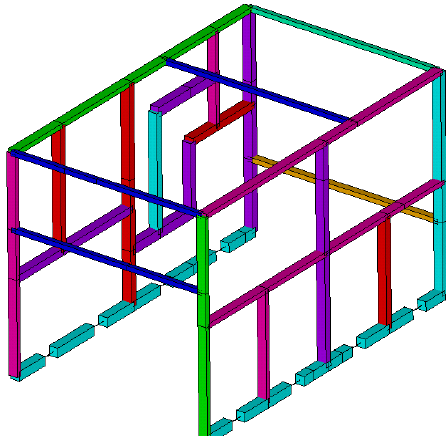
Figure 10. Validation structure modeled with beam-type elements. Beam colors refer to the follow- ing sections employed: Light blue: 80 mm × 80 mm × 3 mm, red: 80 mm × 60 mm × 3 mm, purple: 80 mm × 60 mm × 2 mm, green: 80 mm × 40 mm × 3 mm, lilac: 80 mm × 40 mm × 2 mm, dark blue: 40 mm × 40 mm × 3 mm.